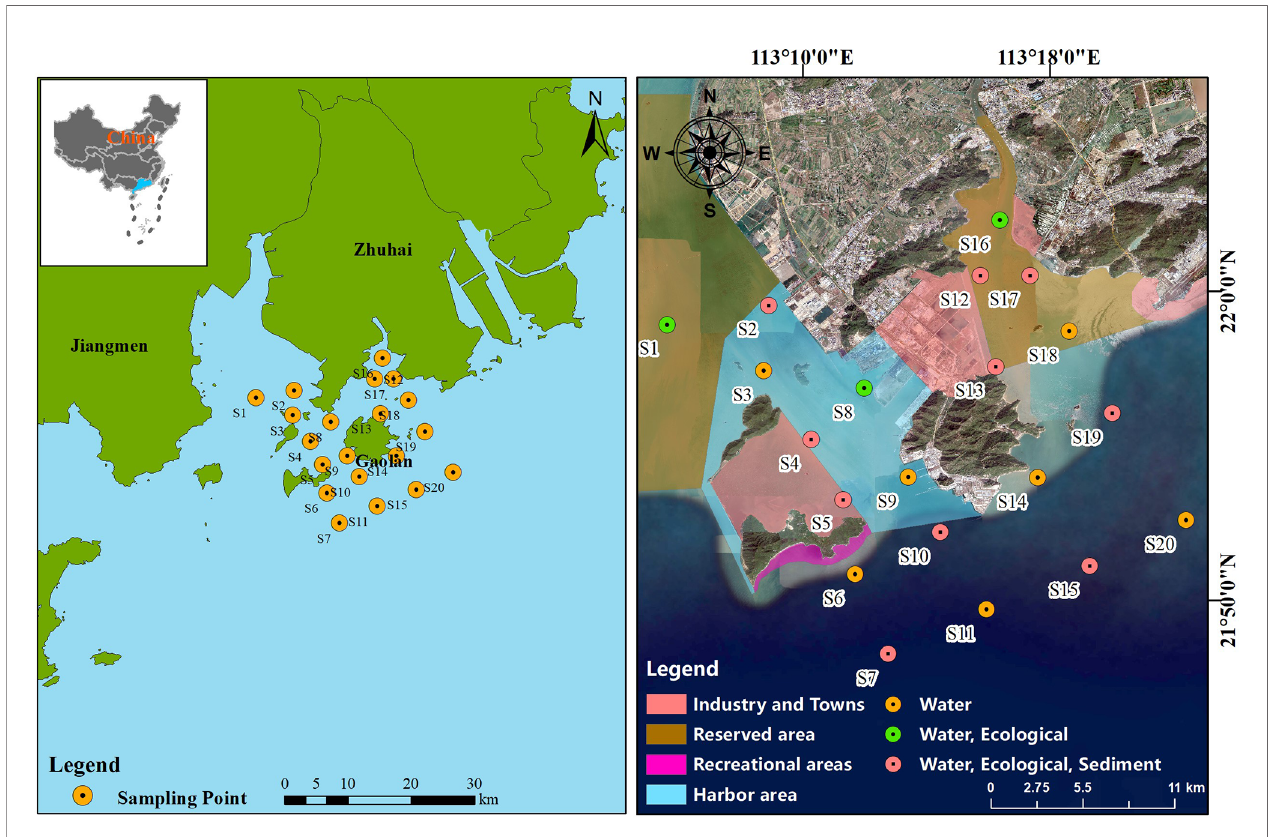
FIGURE 1 | Study area and sampling